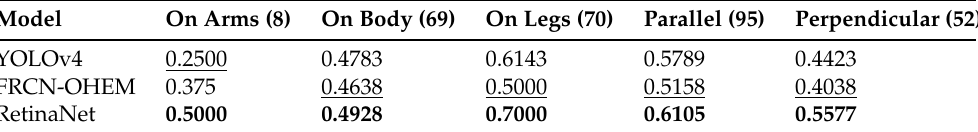
Table 5. Recall rate of detection in different parts of the human body. The detection results of 147 objects in the test set are counted. The results with underline are the worst, and the results with bold are the